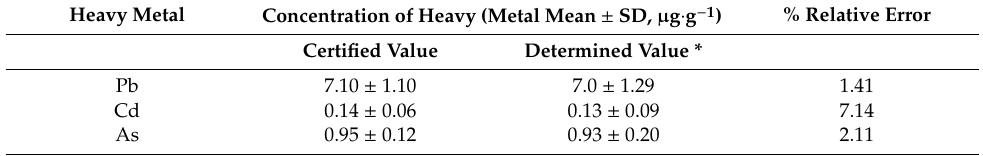
Table 5. ICP-MS determination of Pb, Cd and As in an NCS DC 73,348 bush branches and leaves CRM. Heavy Metal